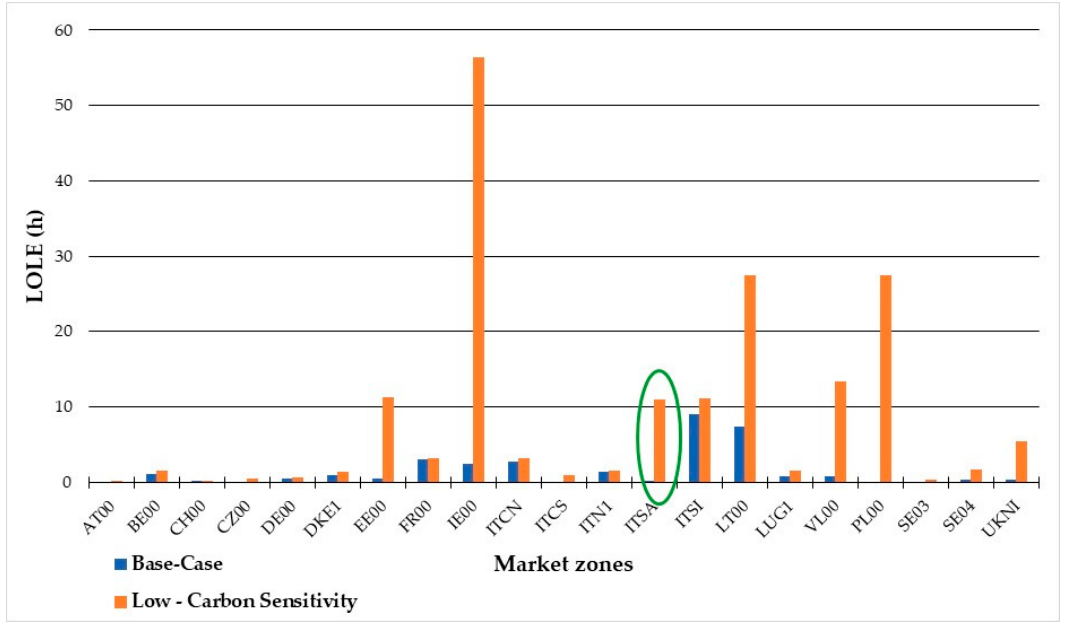
Figure 7. Loss of load expectation (LOLE) values under base-case and low-carbon 2025 scenarios per market zone. Minimum LOLE value: 0.5 h. The green ellipse singles out the market zone: Sardinia [20].